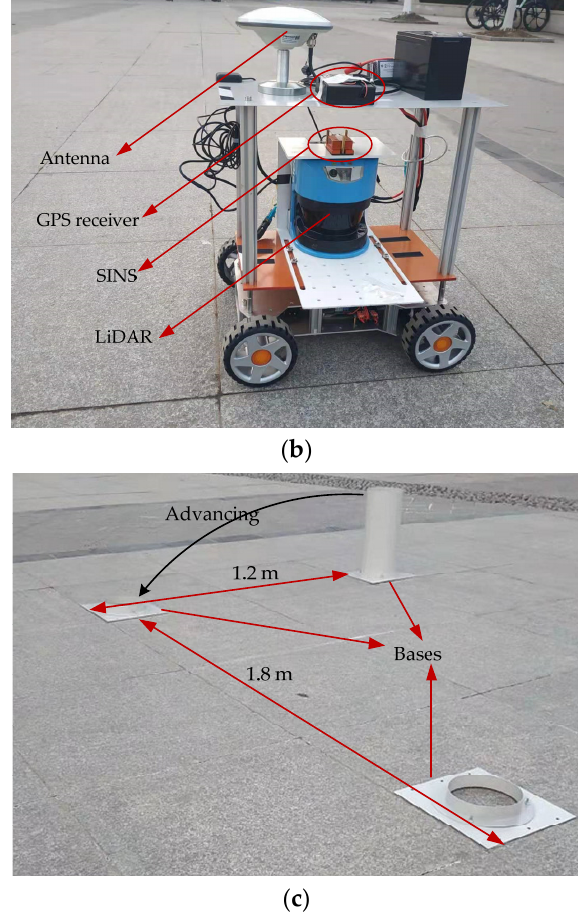
Figure 13. Composition of the experimental platform: ( a ) the overall schematic diagram of the platform; ( b ) mobile carrier and test equipment; ( c ) distribution of cylinders.